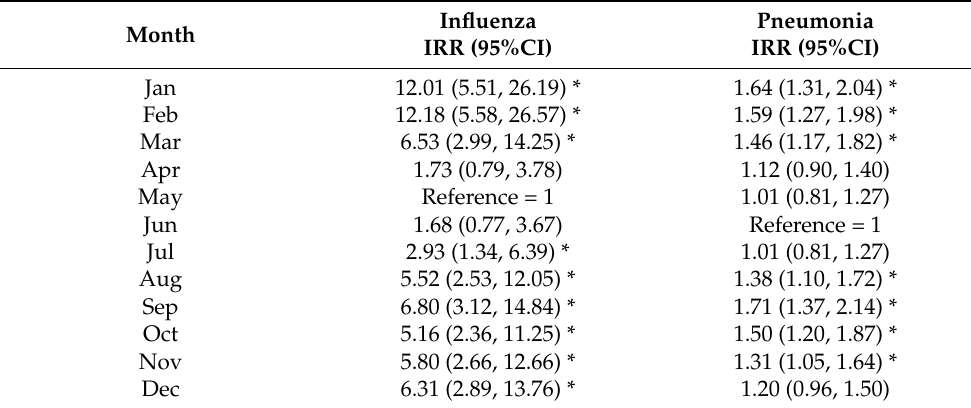
Table 2. Univariate negative binomial regression (NBR) results of influenza and pneumonia incidence rates by month.